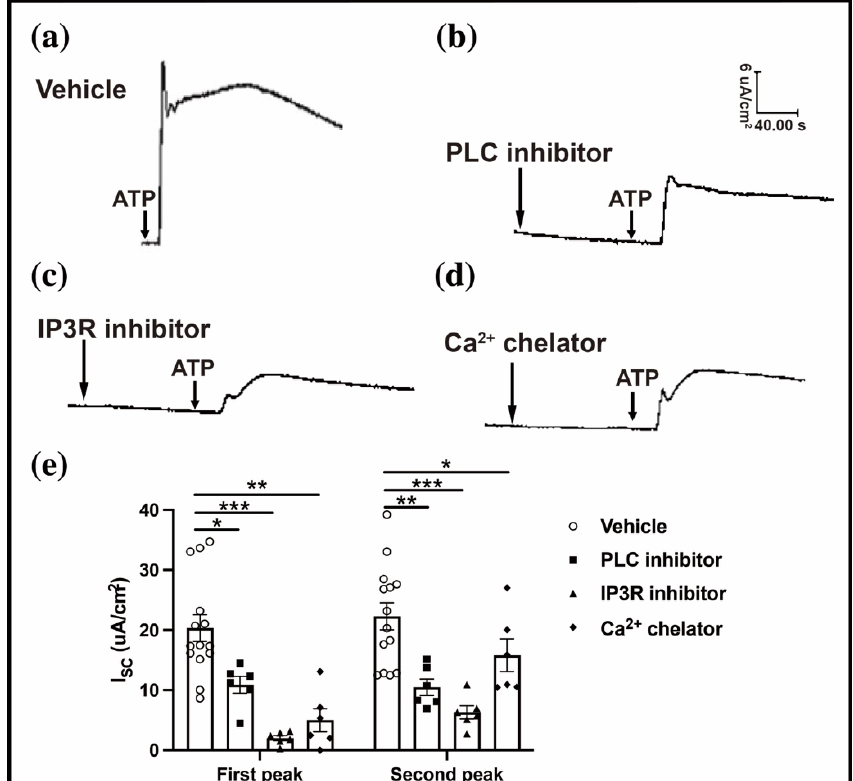
Figure 6. Ca 2+ participates in ATP-induced conjunctival Isc. ( a ) Representative image of ATP-induced conjunctival Isc in the vehicle group. ( b – d ) Representative image of ATP-induced conjunctival Isc in the PLC inhibitor (U73122) group, IP3R inhibitor (2-APB) group, and Ca 2+ chelator (BAPTA/AM) group. ( e ) Bar graph showing the first and second peaks of ATP-induced conjunctival Isc in the vehicle group (n = 14), PLC inhibitor group, IP3R inhibitor group, and Ca 2+ chelator group (n = 6 in each group). Data are represented as mean ± SEM. PLC, phospholipase C; IP3R, inositol (1,4,5) trisphosphate receptor. All results were compared with those of the control group. * p < 0.05, ** p < 0.01, *** p < 0.001.